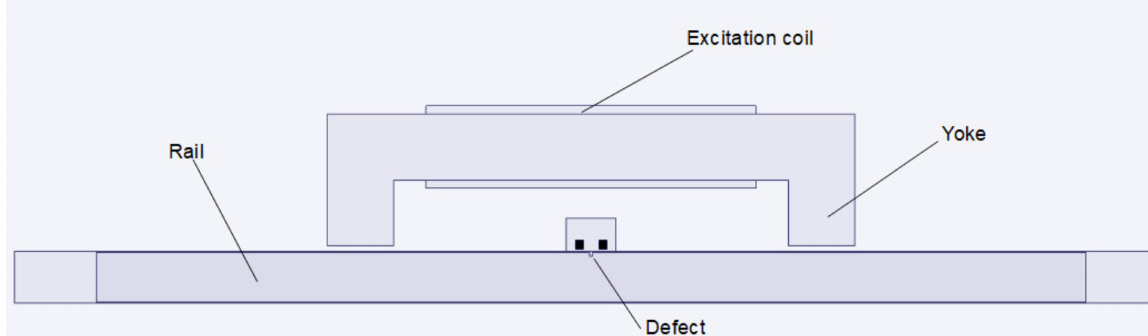
Figure 6. Simulation model.